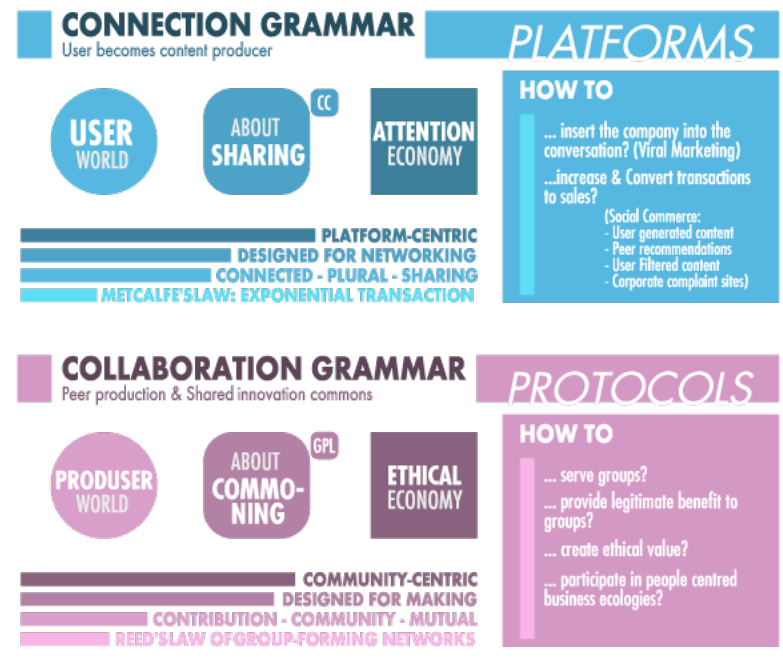
Figure 3: “The Relational Grammar of Internet Communication and Cooperation”